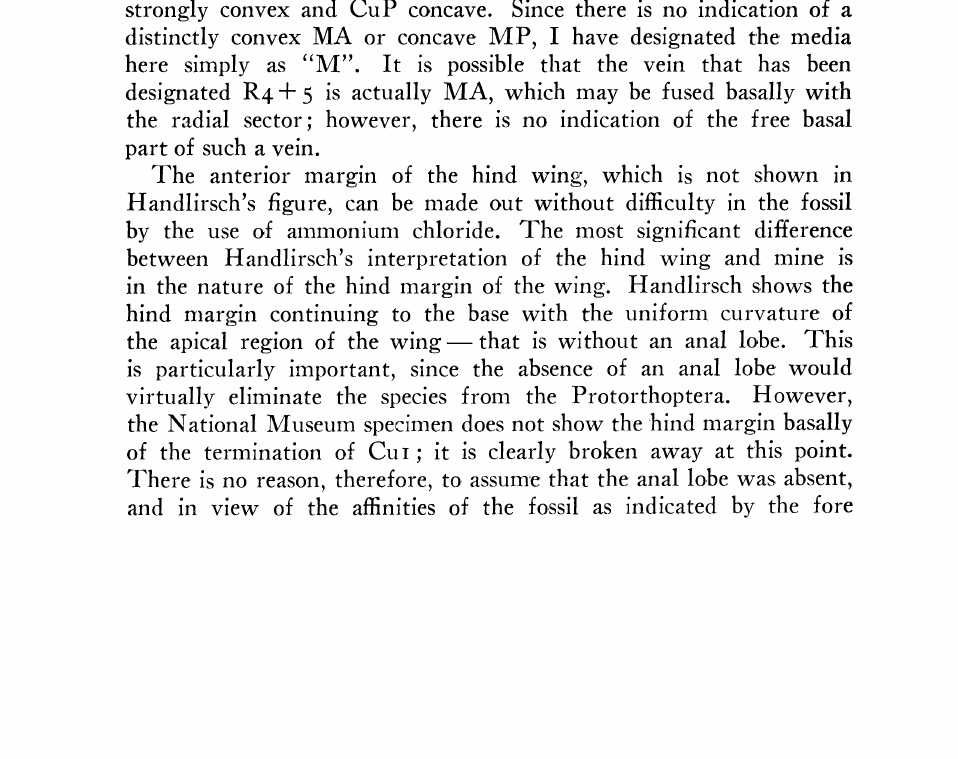
Figure 6. Hadentomum americanum Handlirsch. Drawing of fore wing (A) and hind wing (B). Holotype, no. 35579, U.S.N.M. (original). strongly convex and CuP concave. Since there is no indication of a distinctly convex MA or concave. MP, I have designated the media here simply as "M". It is possible that the vein that has been designated R4+ 5 is actually MA, which may be used basally with the radial sector; however, there is no indication of the free basal o such part a